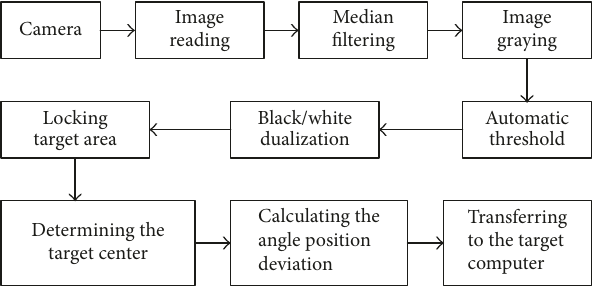
Figure 14: Video processing block